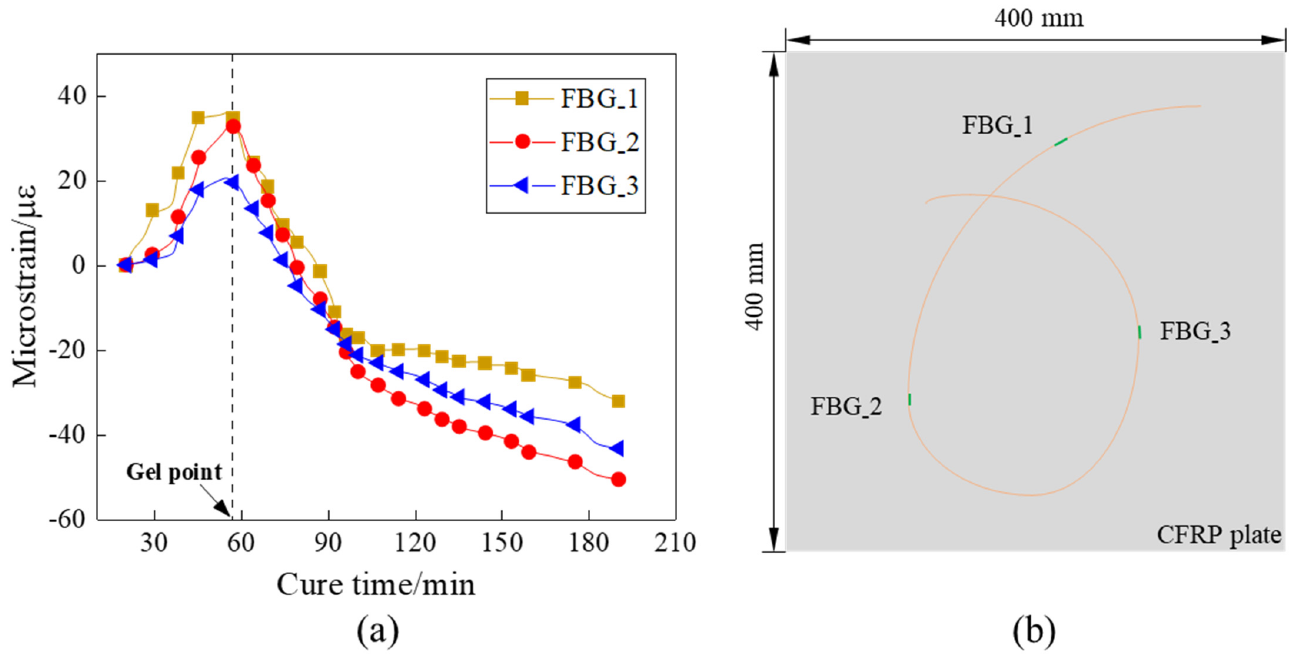
Figure 5. ( a ) The strain field of FBG sensors. ( b ) Schematic diagram of FBG sensors layout.